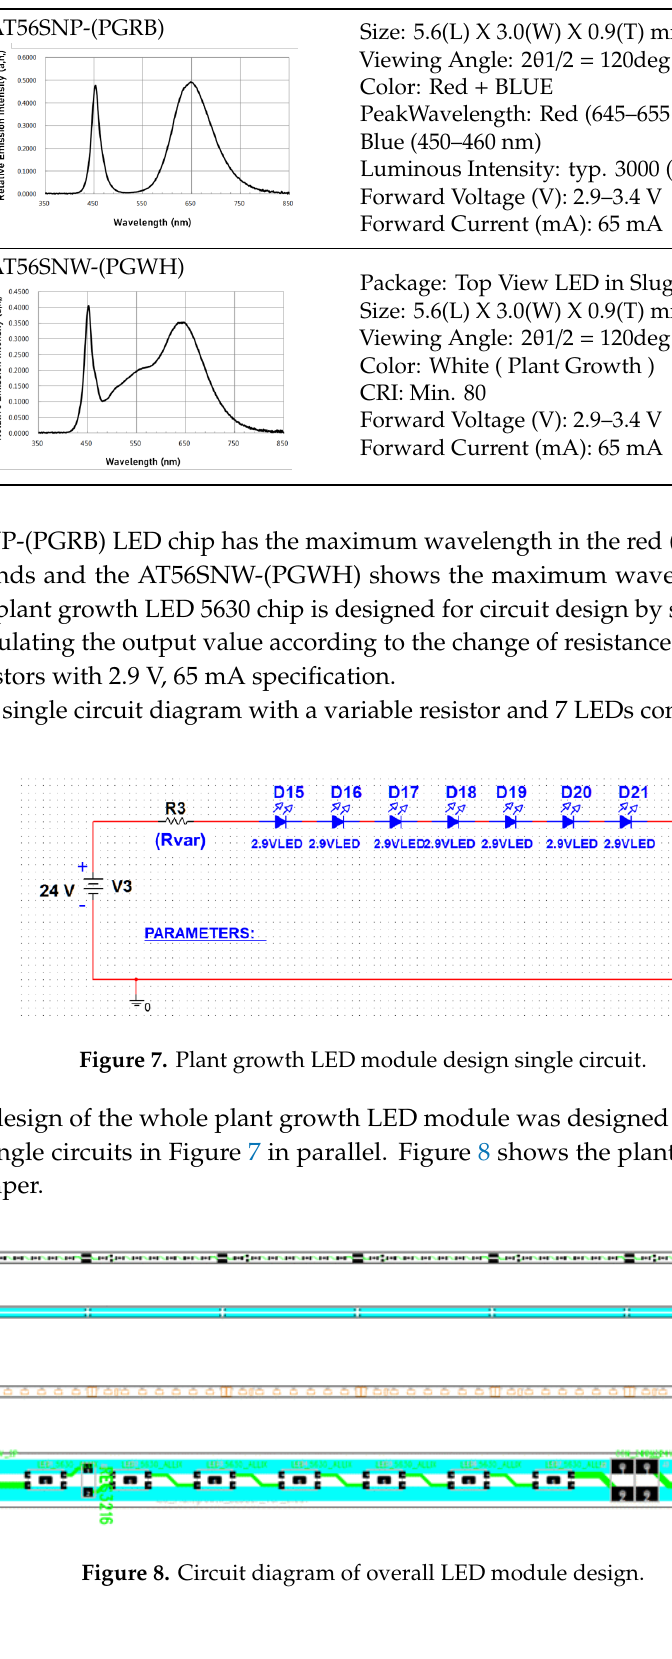
Table 1. Specification of plant growth LED chip. AT56SNP-(PGRB)